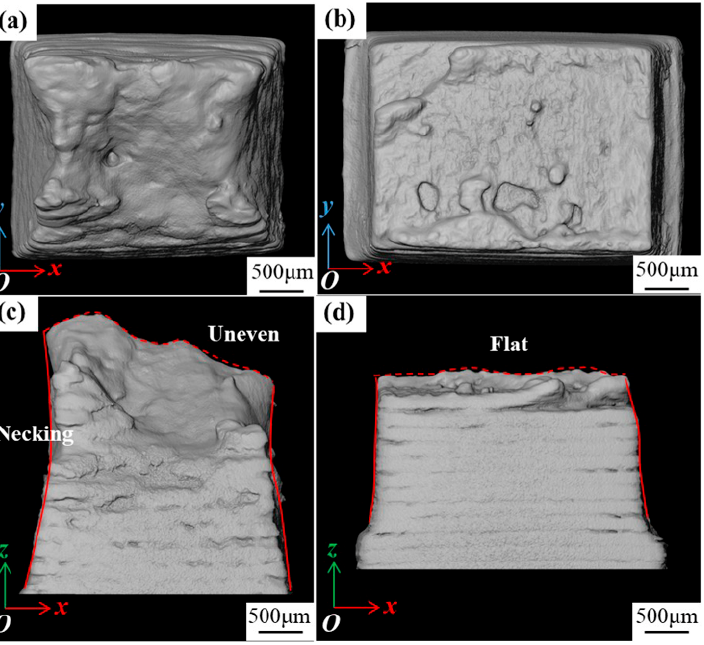
Figure 6. Fracture morphology of ( a , c ) Specimen 400 and ( b , d ) Specimen 1000 obtained by XCT reconstruction.